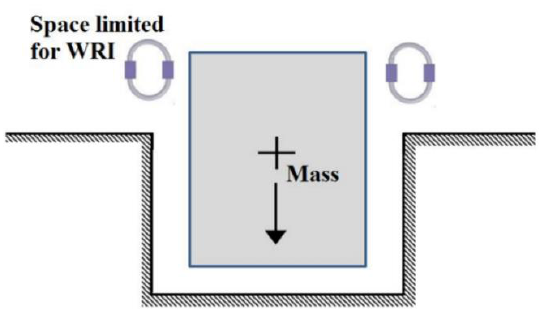
Table 3. S-WRI configurations. Figure 4. Limited space to insert WRIs. Figure 4. Limited space to insert WRIs. Figure 4. Limited space to insert WRIs.